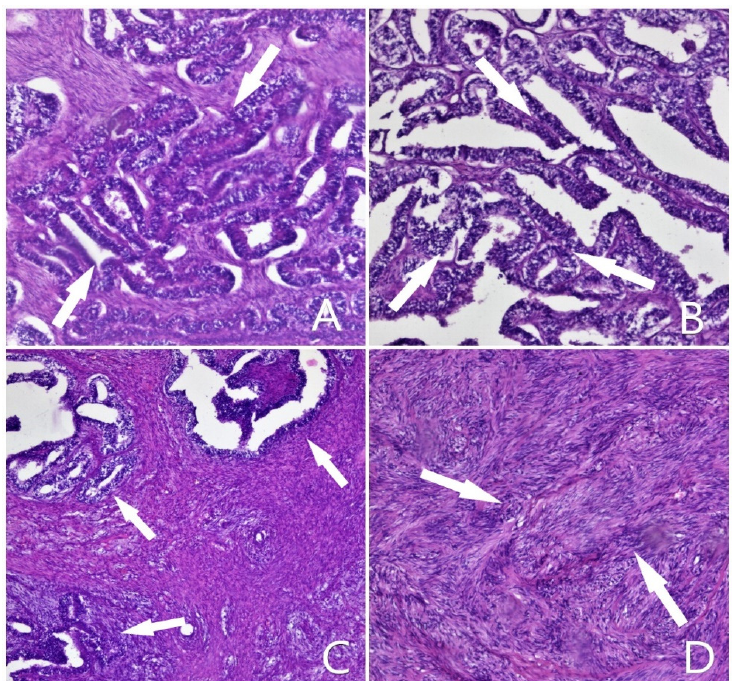
Figure 1. ( A , C ) Hiperplastic endometrial glands, arranged ”back-to-back”, in a dense, myomatous stroma–HE (Hematoxiline and Eosine), ob. 10×; ( B ) Epithelial component–in detail–HE, ob. 20×; ( D ) Mezenchimal component, without atypia–detail–Hematoxiline and Eosine (HE), ob. 10×. (Indicated by arrow).